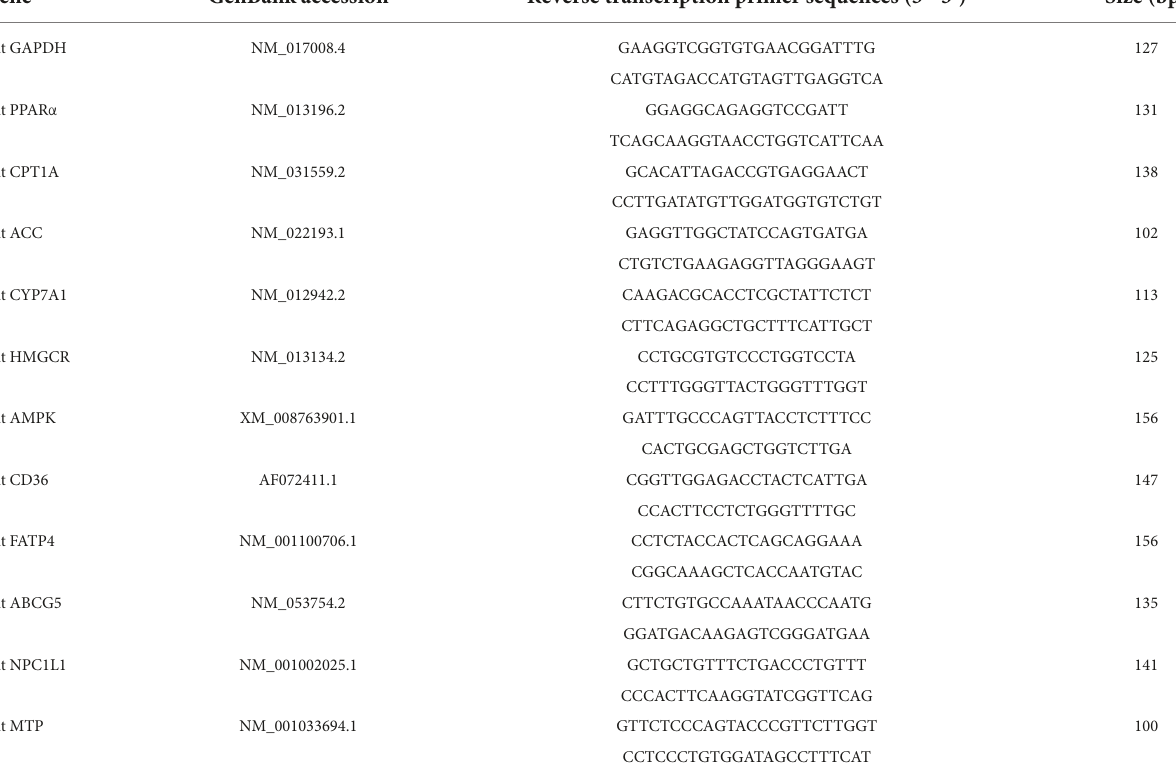
TABLE 1 Real-time PCR primers in rat liver and small intestine. Gene